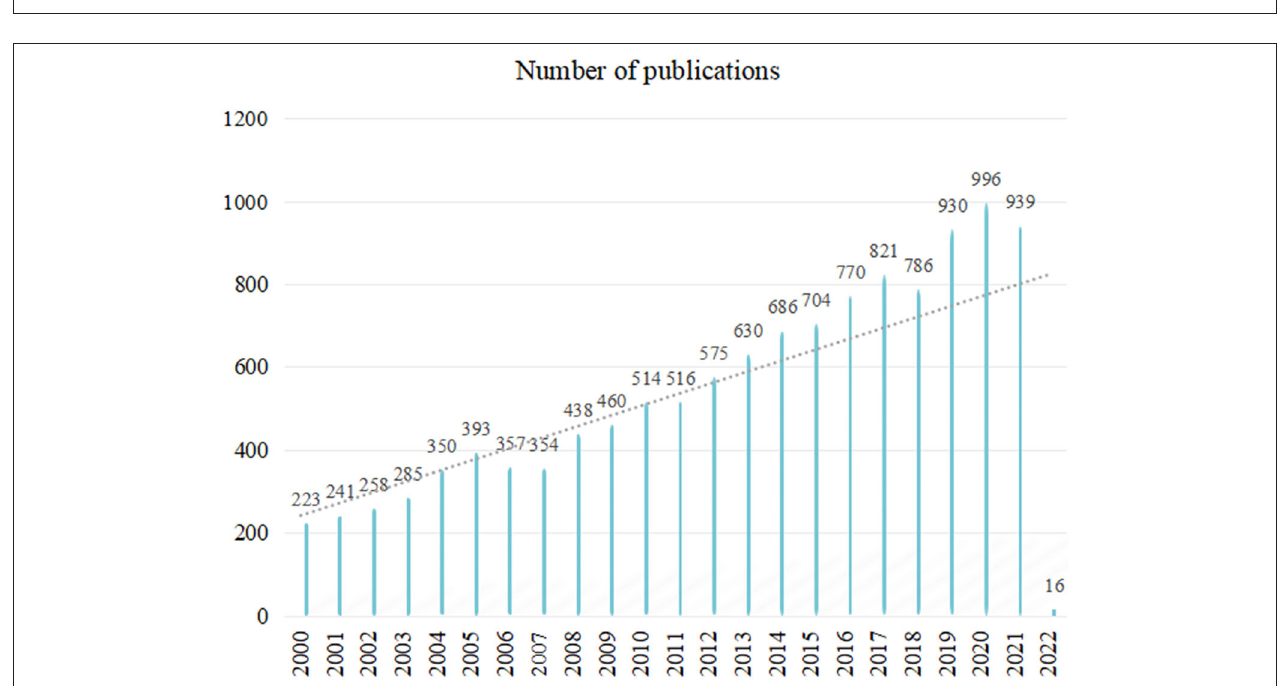
FIGURE 3 | Number of publications per year and growth trend for low back pain